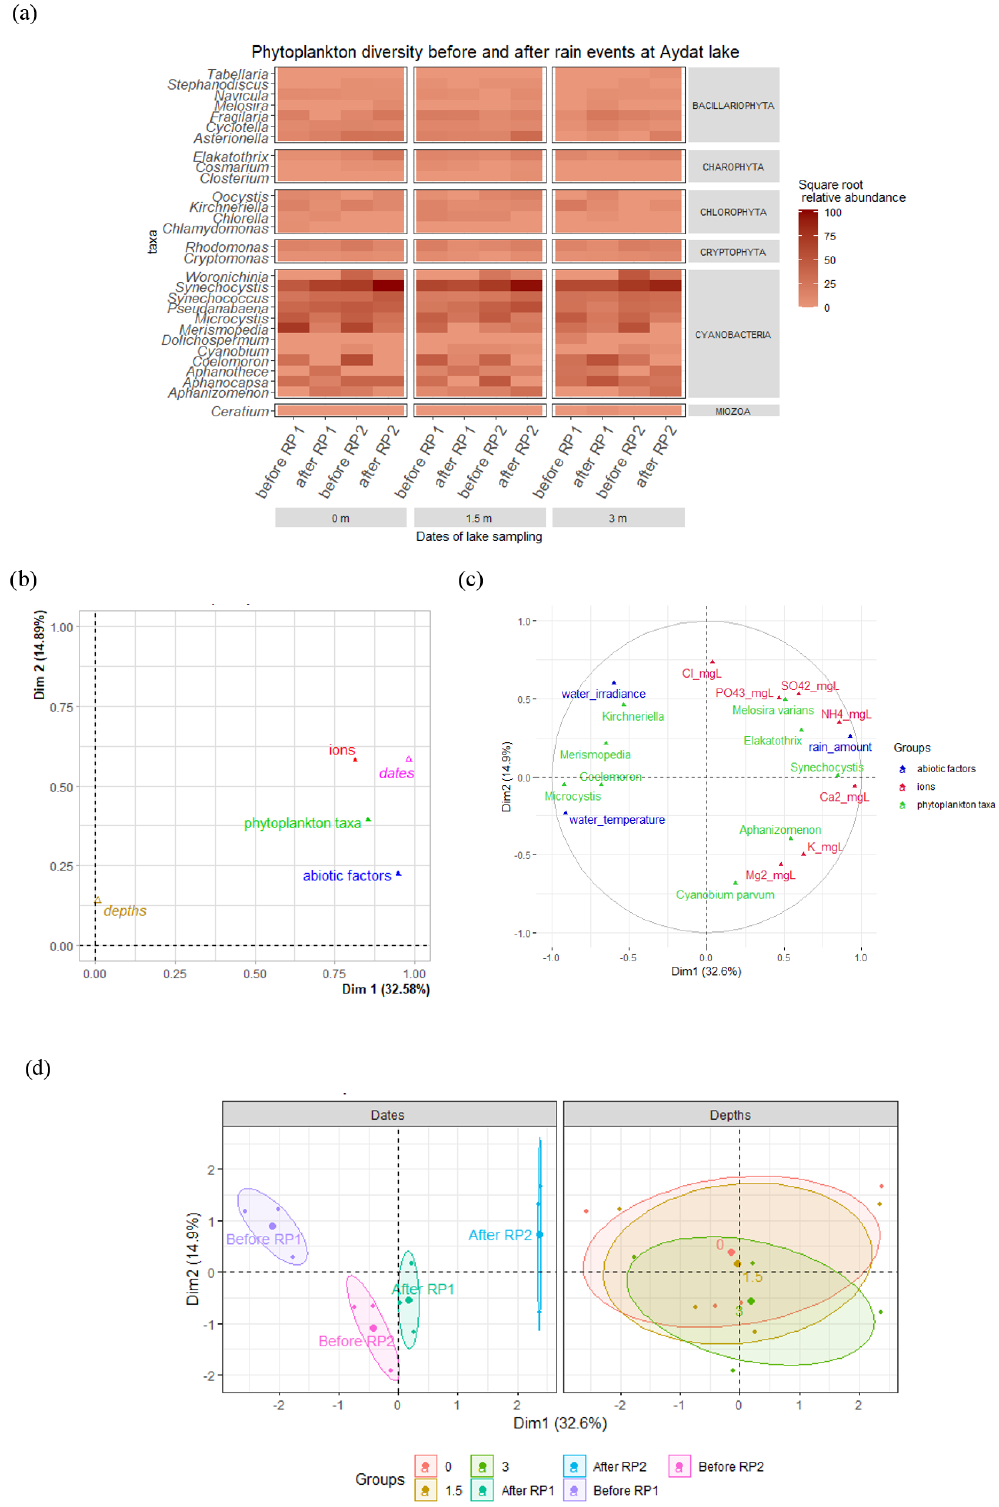
Figure 8. (a) Heatmap showing the square root transformed relative abundance of phytoplankton with respect to depth and the rain periods. (b) Multiple factor analysis (MFA) – projection of groups of variables. (c) Correlation circle map of the MFA. For clarity, only variables with a cos2 higher than 0.45 are represented in the correlation circle. (d) Individual factor map, showing the position of samples in the MFA with confidence ellipses around “depths” (0, 1.5, and 3m) and “dates” (before and after rain period 1 and 2)